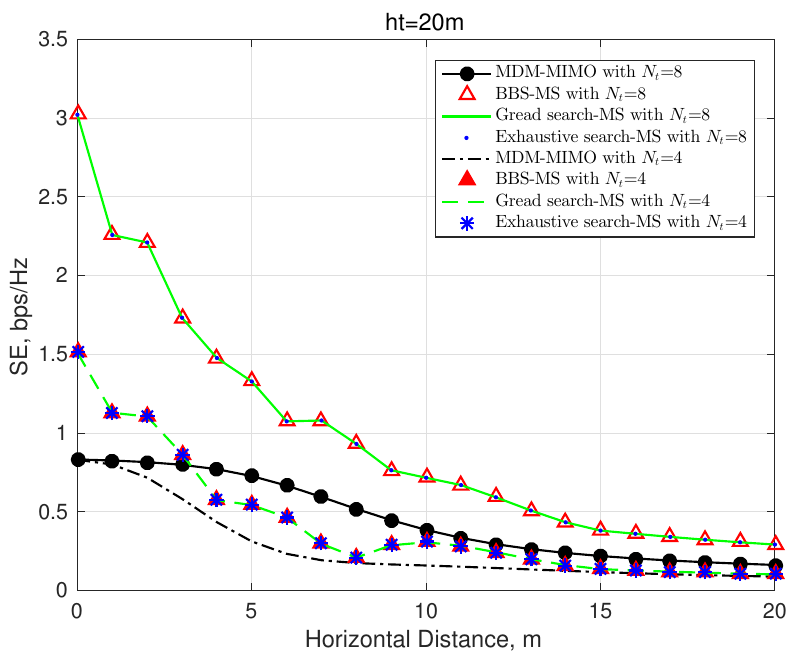
Figure 5. Spectrum efficiency, R = 20 λ , SNR = 20 dB, and L =